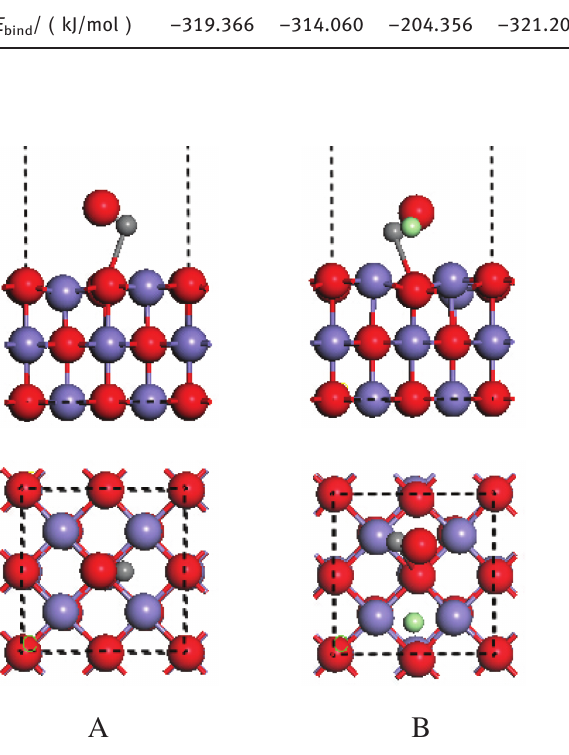
Figure 8: Adsorption configuration of CO adsorption on